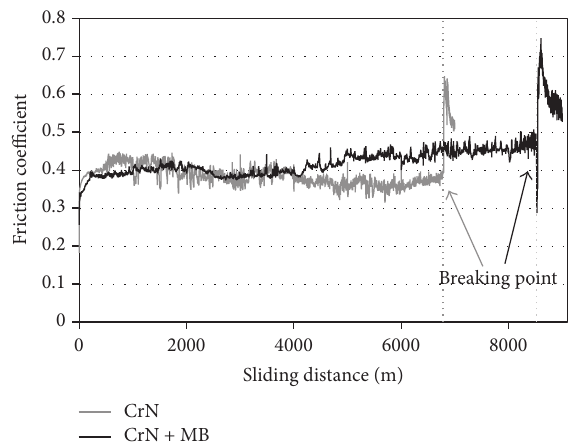
Figure 7: Example of friction coefficient curves for long run test.